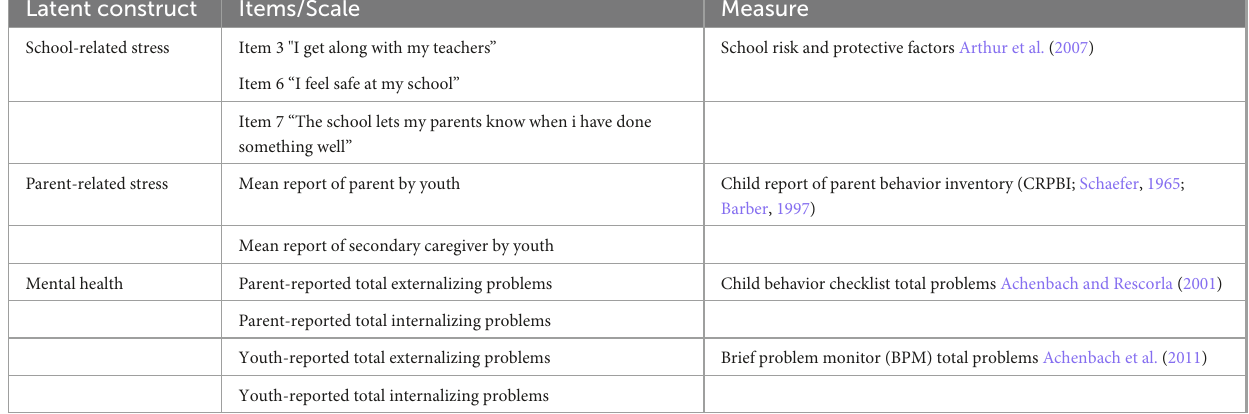
TABLE 3 Latent construct and